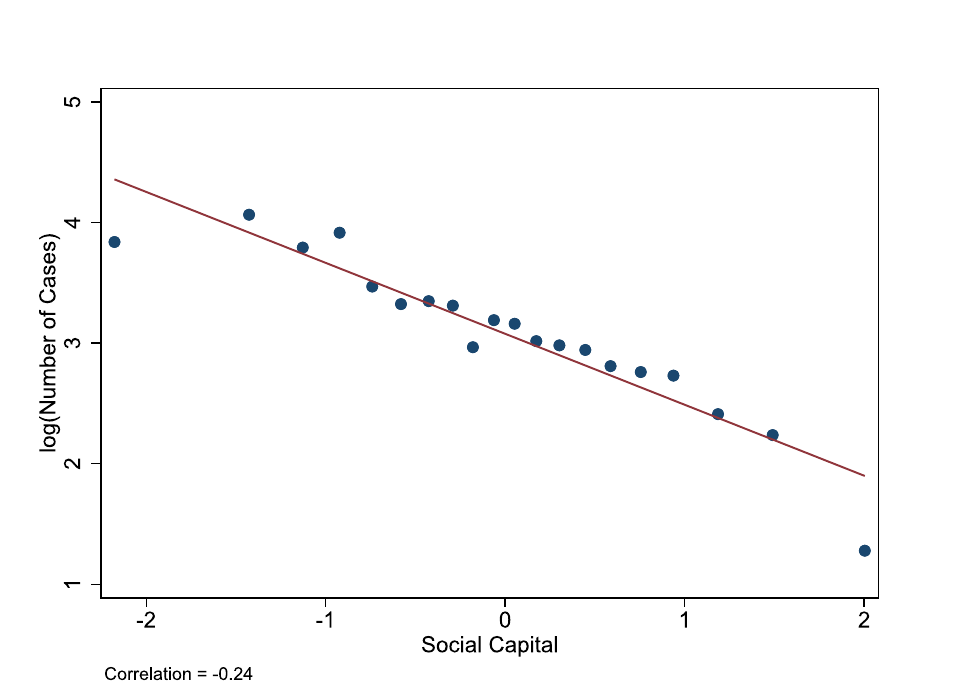
Fig 3. The relationship between infections and social